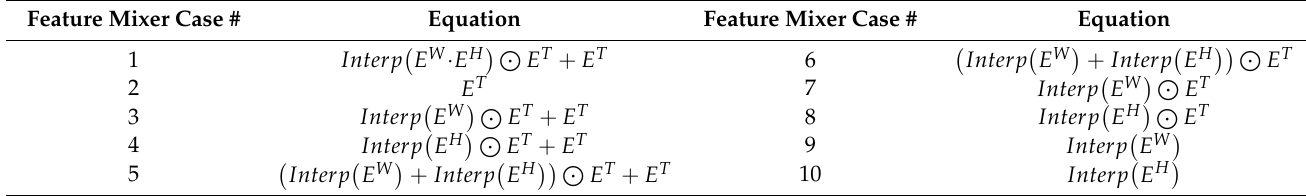
Figure 2. Type of feature mixer. Table 3. Ten types of feature mixer.